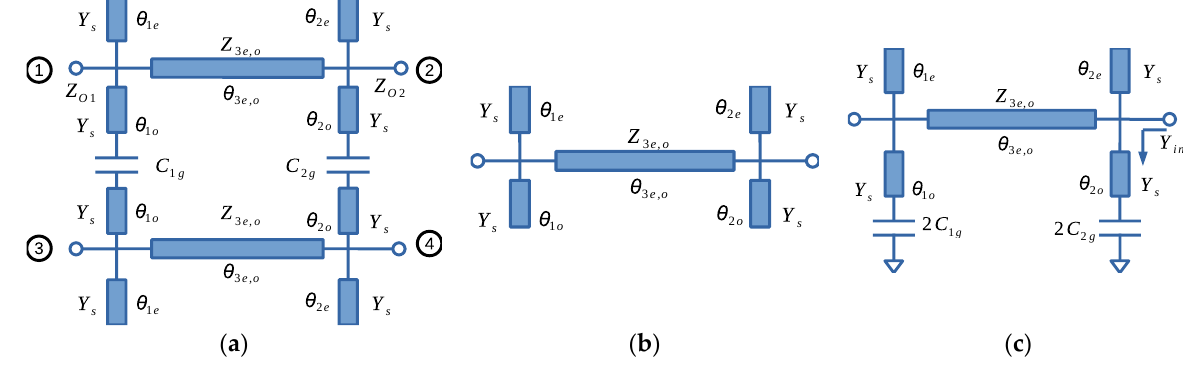
Figure 4. Distributed equivalent circuit of coupler: ( a ) Total equivalent circuit; ( b ) even-mode equiv- alent circuit; ( c ) odd-mode equivalent circuit.